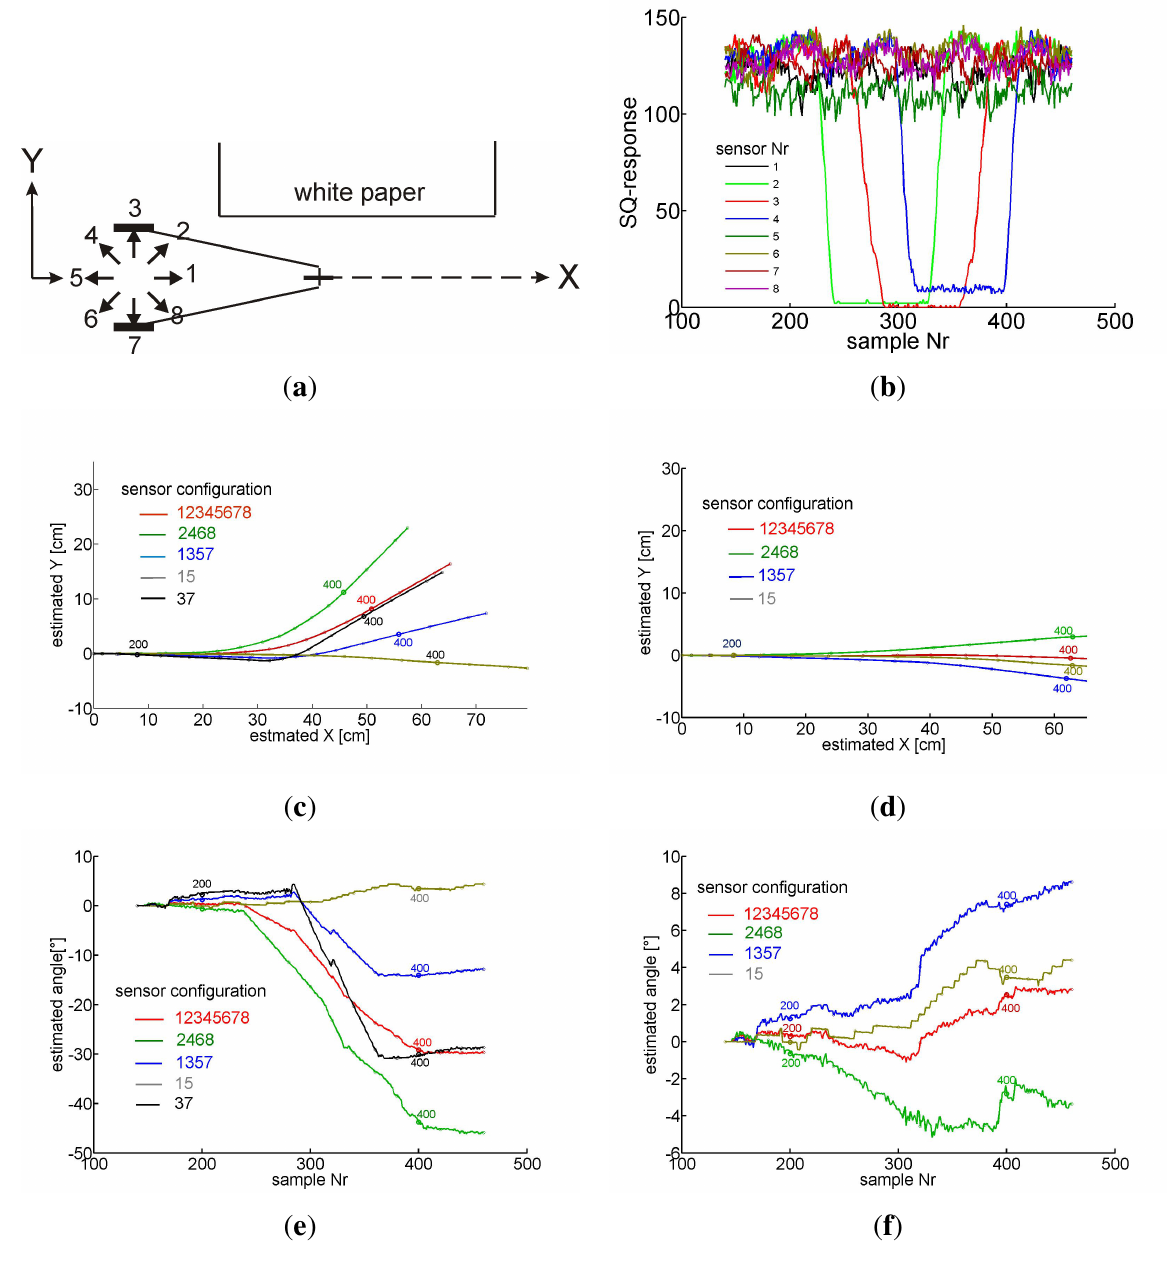
Figure 11. ( a ) the carriage is pushed along a straight line with a blank sheet of white paper on its left side. Eight numbered arrows indicate the azimuth of the eight mouse sensors; ( b ) The SQ -responses of the sensors are plotted versus the sample number. Only sensors 2, 3, 4 look to the blank zone, one after the other, while their SQ -response drops to low numbers; ( c ) The estimated X, Y -position of the vehicle using the responses of different sensor combinations, neglecting their SQ -responses ( d ) estimated X, Y -position of the vehicle using for each frame only sensors with SQ -response larger than the threshold of 90 ( e ) the evaluated angle of the vehicle’s path when the SQ -responses are neglected and ( f ) when for each frame only sensors with SQ -response larger than 90 are used. In (c), (d), (e), (f) every 20th sample is marked by a point and every 200th sample by a number. Note the